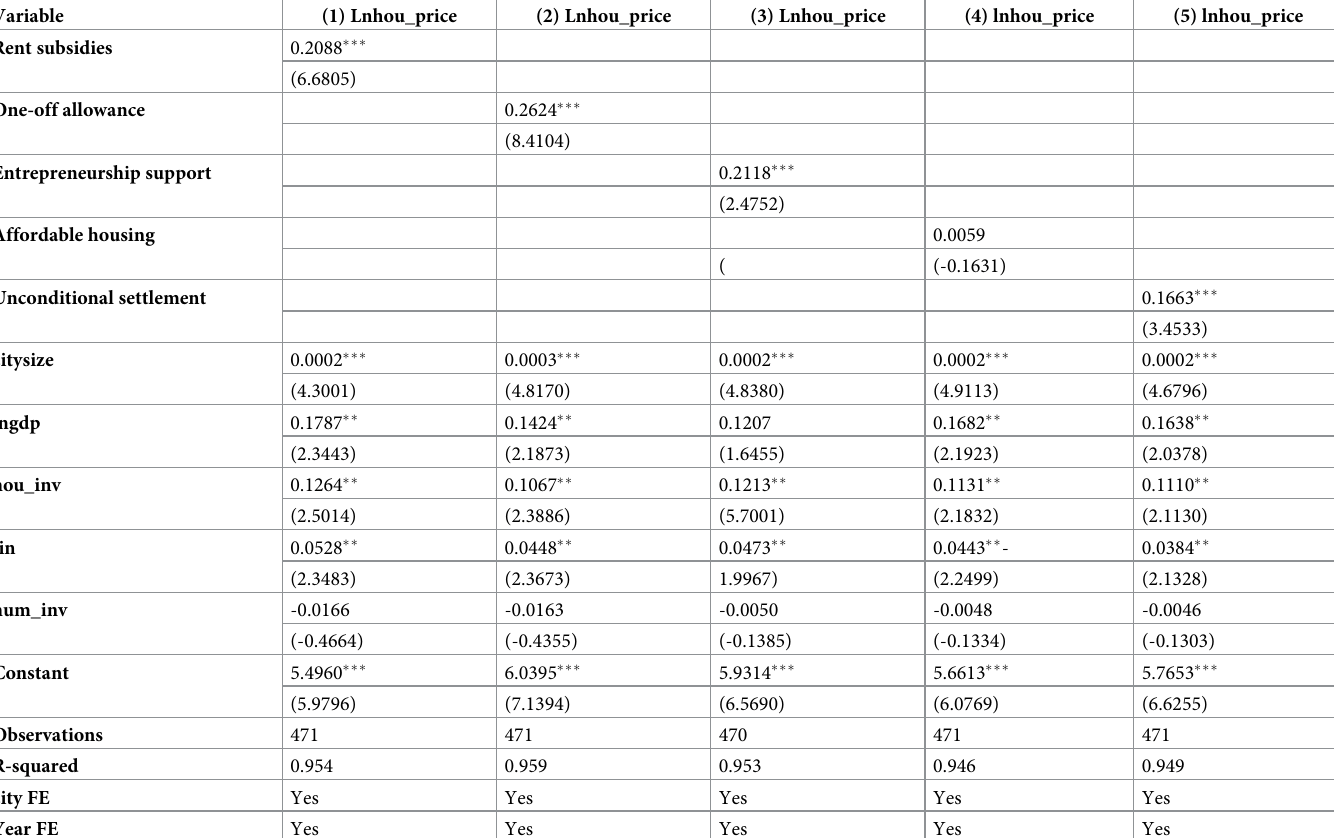
Table 10. The impact of different policy tools on housing